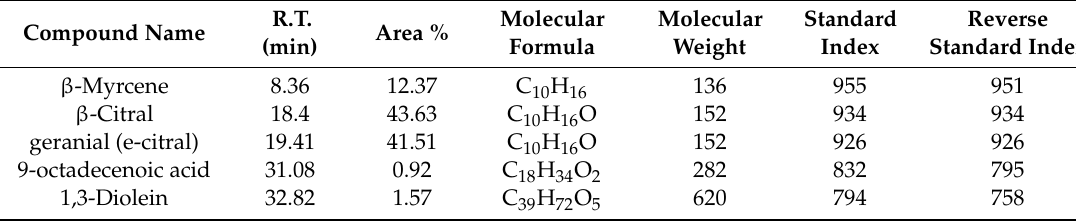
Table 2. Chemical composition of the EO from lemongrass leaves.